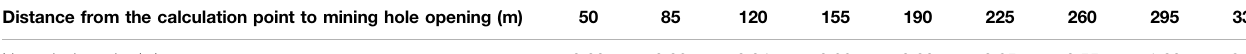
TABLE 11 | Inelastic zone width of the coal pillar calculated by numerical calculation and numerical simulation under the 100% fi lling rate condition. Distance from the calculation point to mining hole opening (m) 50 Numerical results